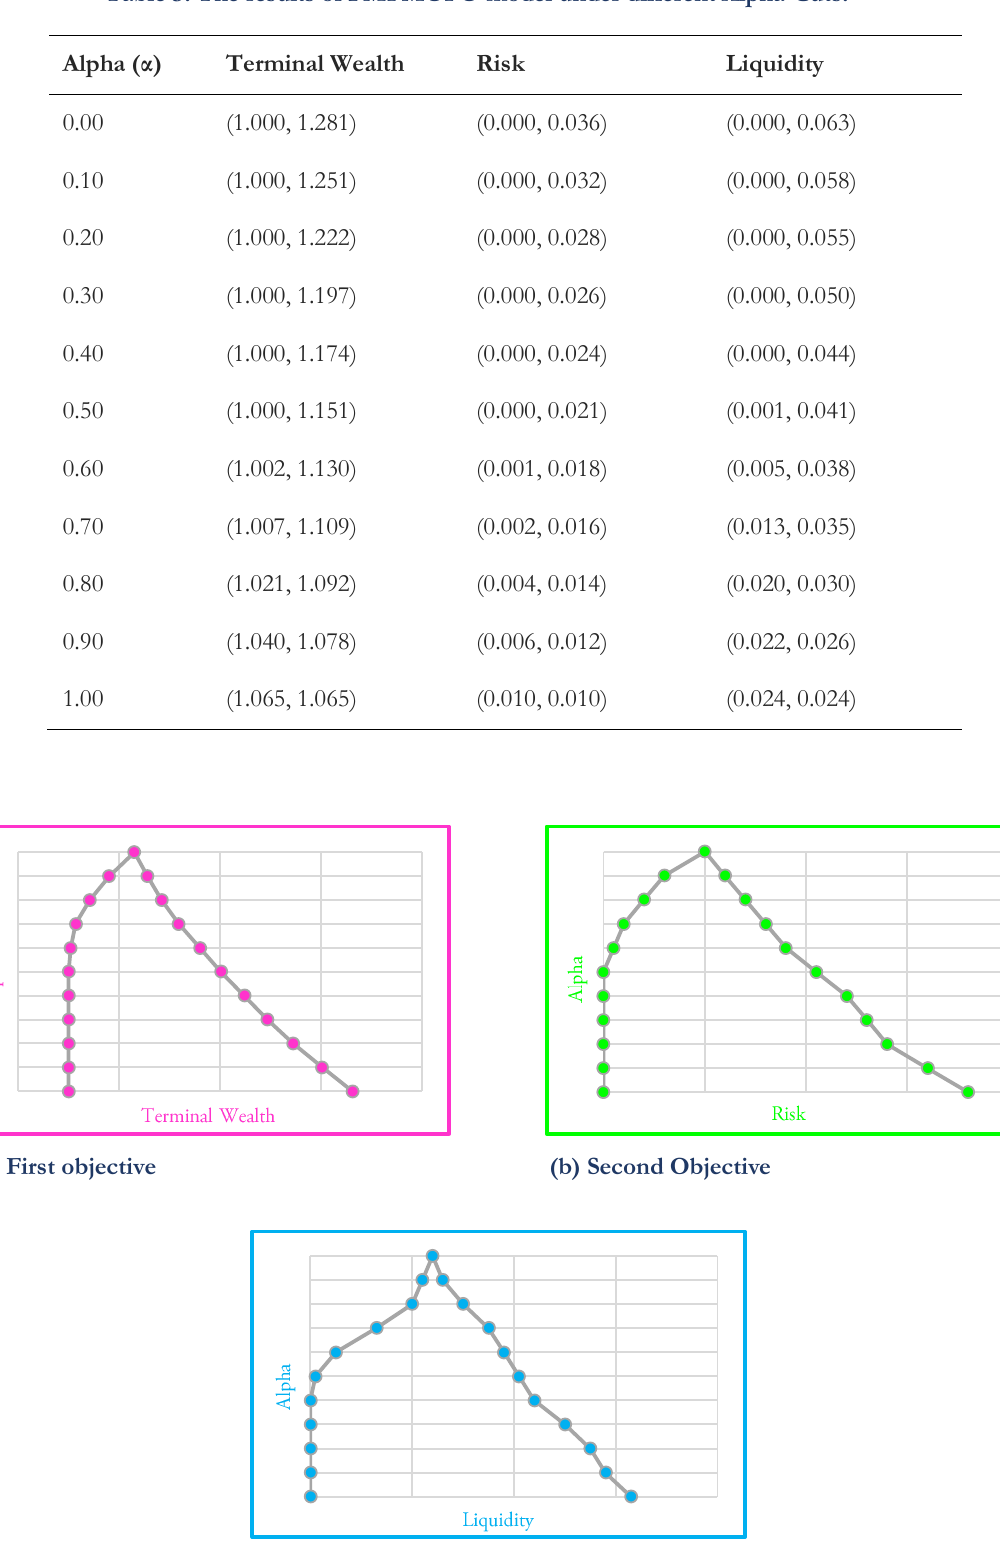
Table 3. The results of FMPMOPO model under different Alpha-Cuts.